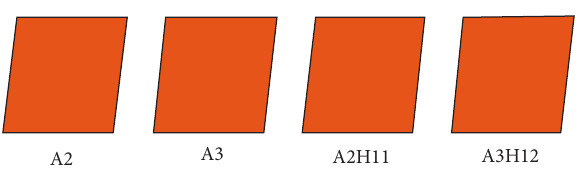
Figure 5: The fabrication composites